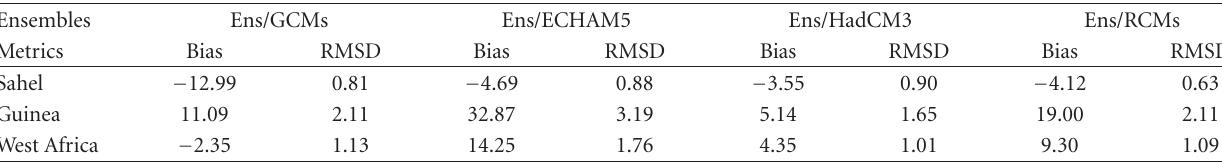
Table 6: Mean bias and spatial root mean square di ff erence (RMSD) at di ff erent sub-domains considered in Figure 1(b) from the ensemble of GCMs (Ens/GCMs), the ensemble of RCMs driven by the same GCMs (Ens/ECHAM5 and Ens/HadCM3), and the ensemble of all RCMs (multi-model ensemble: Ens/RCMs) rainfall with respect to GPCP. Ensembles data are interpolated to GPCP grid. Bias is expressed as percentage of GPCP value while RMSD as